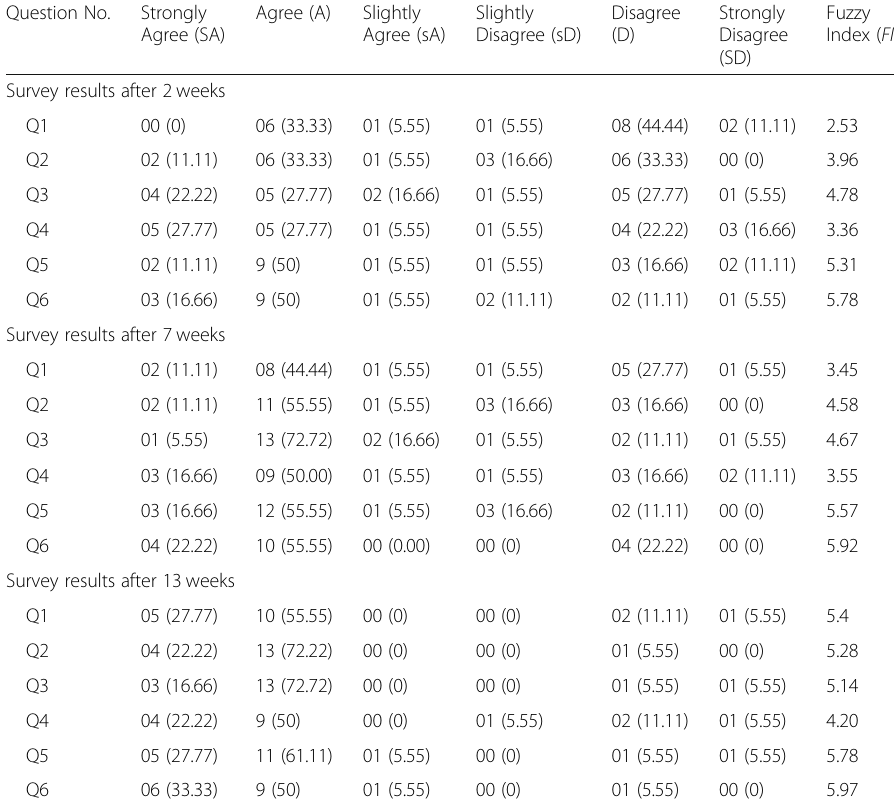
Table 4 Student survey results with the number and percentage of responses Question No. Strongly Agree (A) Slightly Slightly Agree (SA) Agree (sA) Disagree (sD)